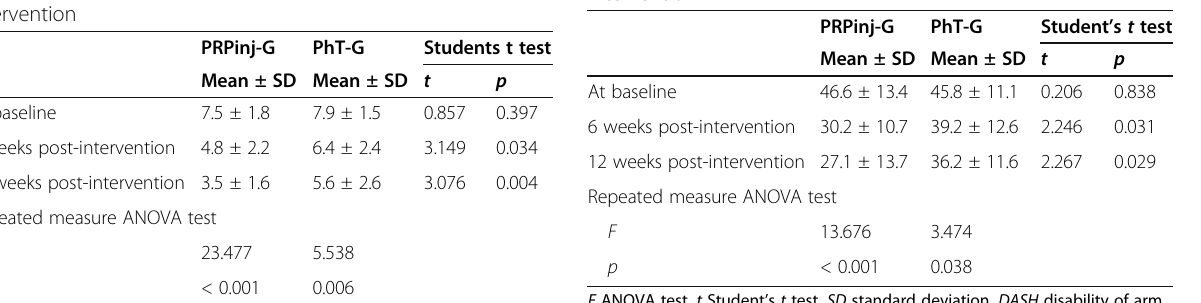
Right shoulder affected (n, %) Location of tear